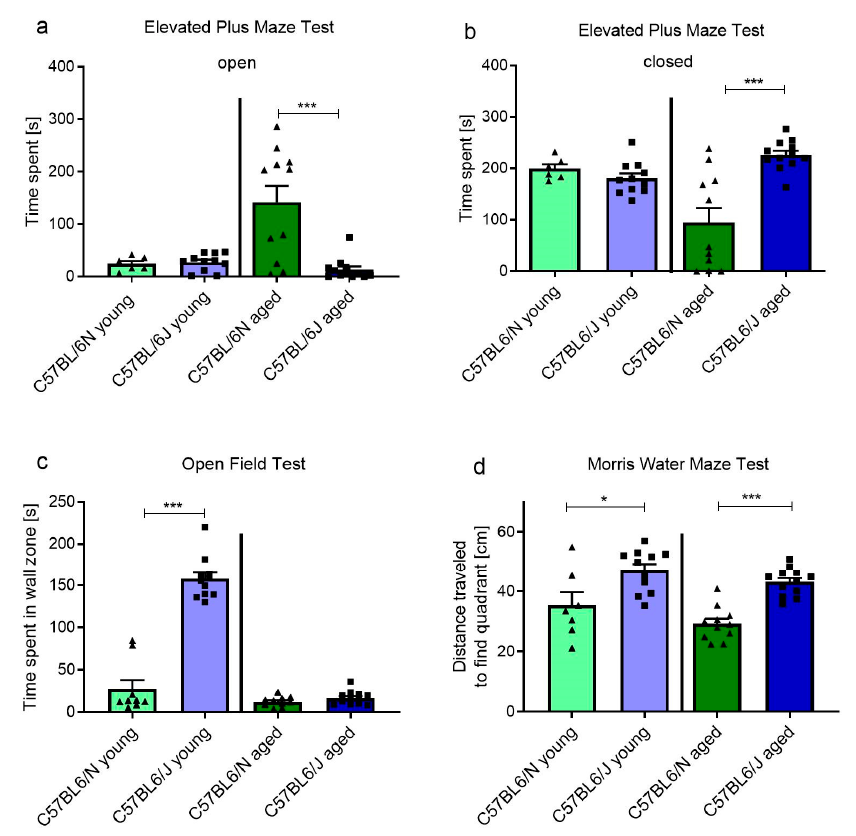
Figure 6. Behavior of C57BL/6N and C57BL/6J mice in ( a , b ) EPM, ( c ) OF and ( d ) Morris Water Maze (MWM) tests. Time spent in the ( a ) open and ( b ) closed arms of the EPM, ( c ) frequency of center entrances in the OF and ( d ) distance traveled to find the platform quadrant in the MWM. Values are represented as mean ± SEM, n = 6–11 animals per group, * p < 0.05, *** p < 0.001. OF: Open Field.